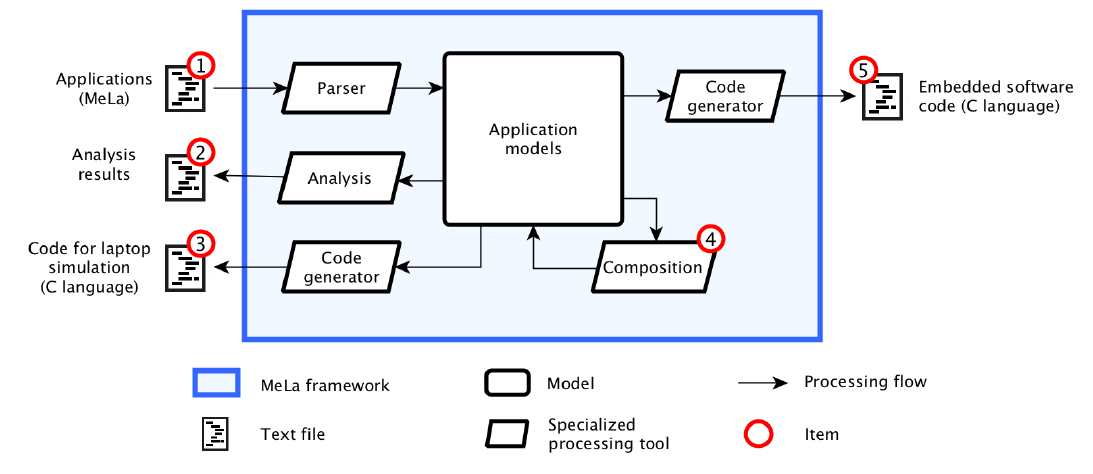
Figure 1. Models used in